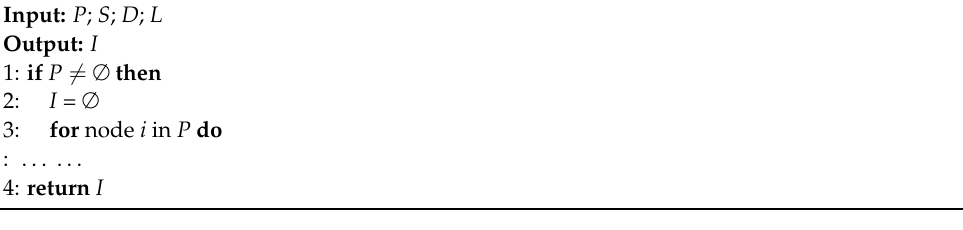
Algorithm A1 Proactive Approach—T or ECMP-T or Fermat-point Model